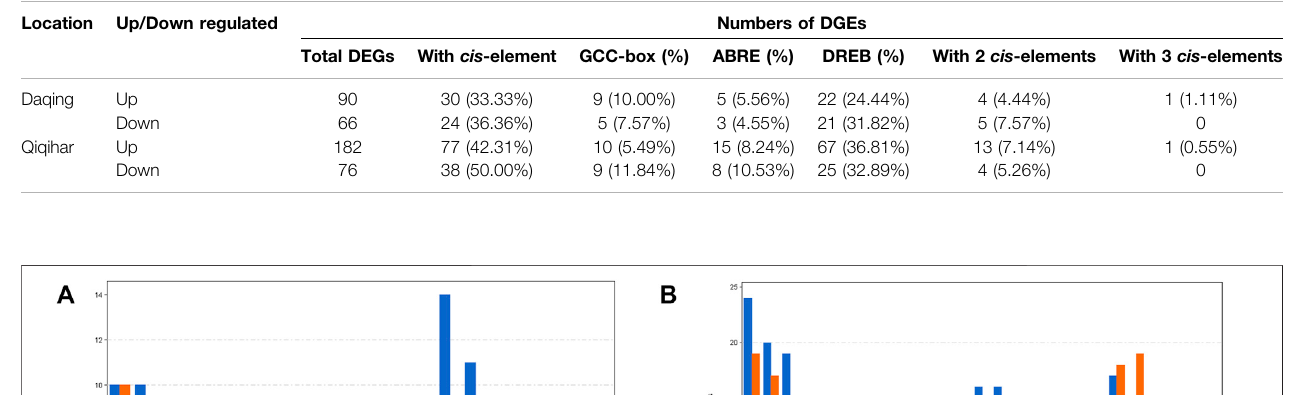
Frontiers in Bioengineering and Biotechnology |